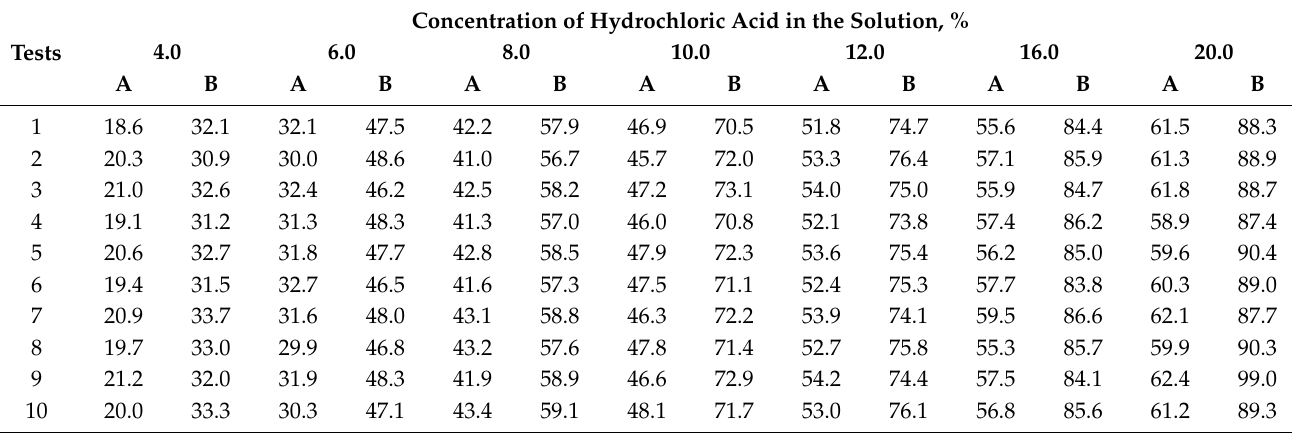
Table 6. Copper extraction (%) without mechanical activation (A) and with mechanical activation